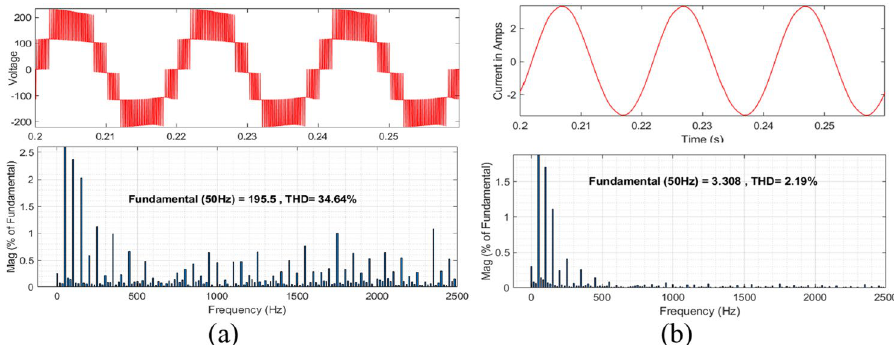
Figure 12. Totalharmonic distortion ( a ) for Voltage and ( b ) for current.